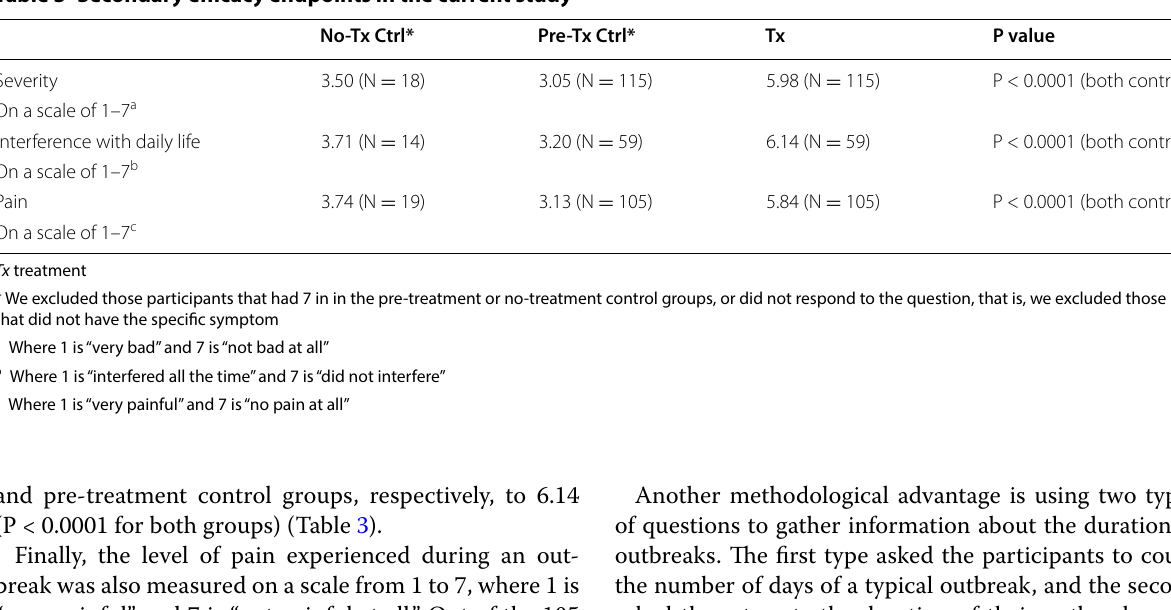
Table 3 Secondary efficacy endpoints in the current